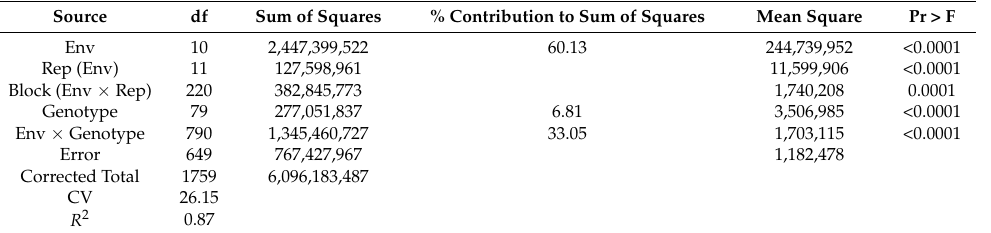
Table 4. Combined analysis of variance for grain yield of 80 hybrids across eleven environments. Source df Sum of Squares % Contribution to Sum of Squares Mean Square Pr > F Env